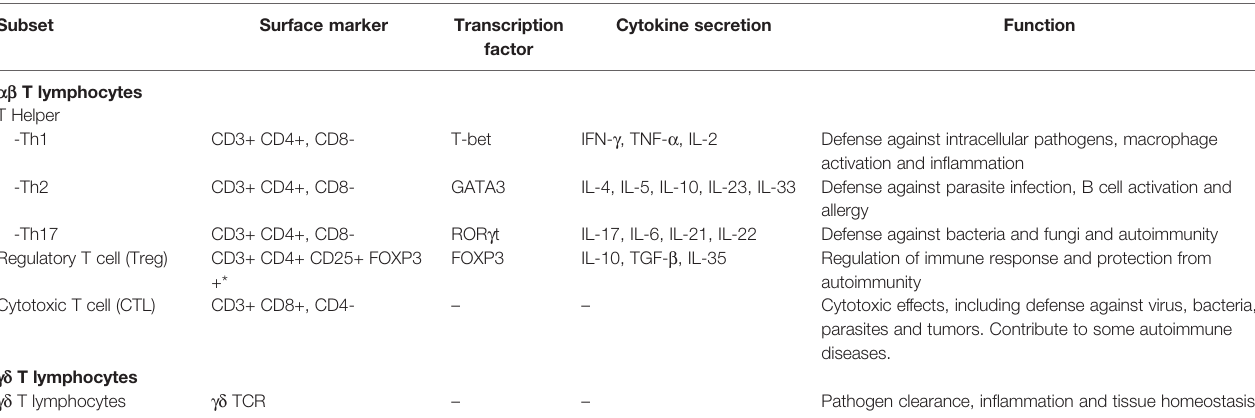
TABLE 1 | Major T cell subsets involved in the post-stroke immune